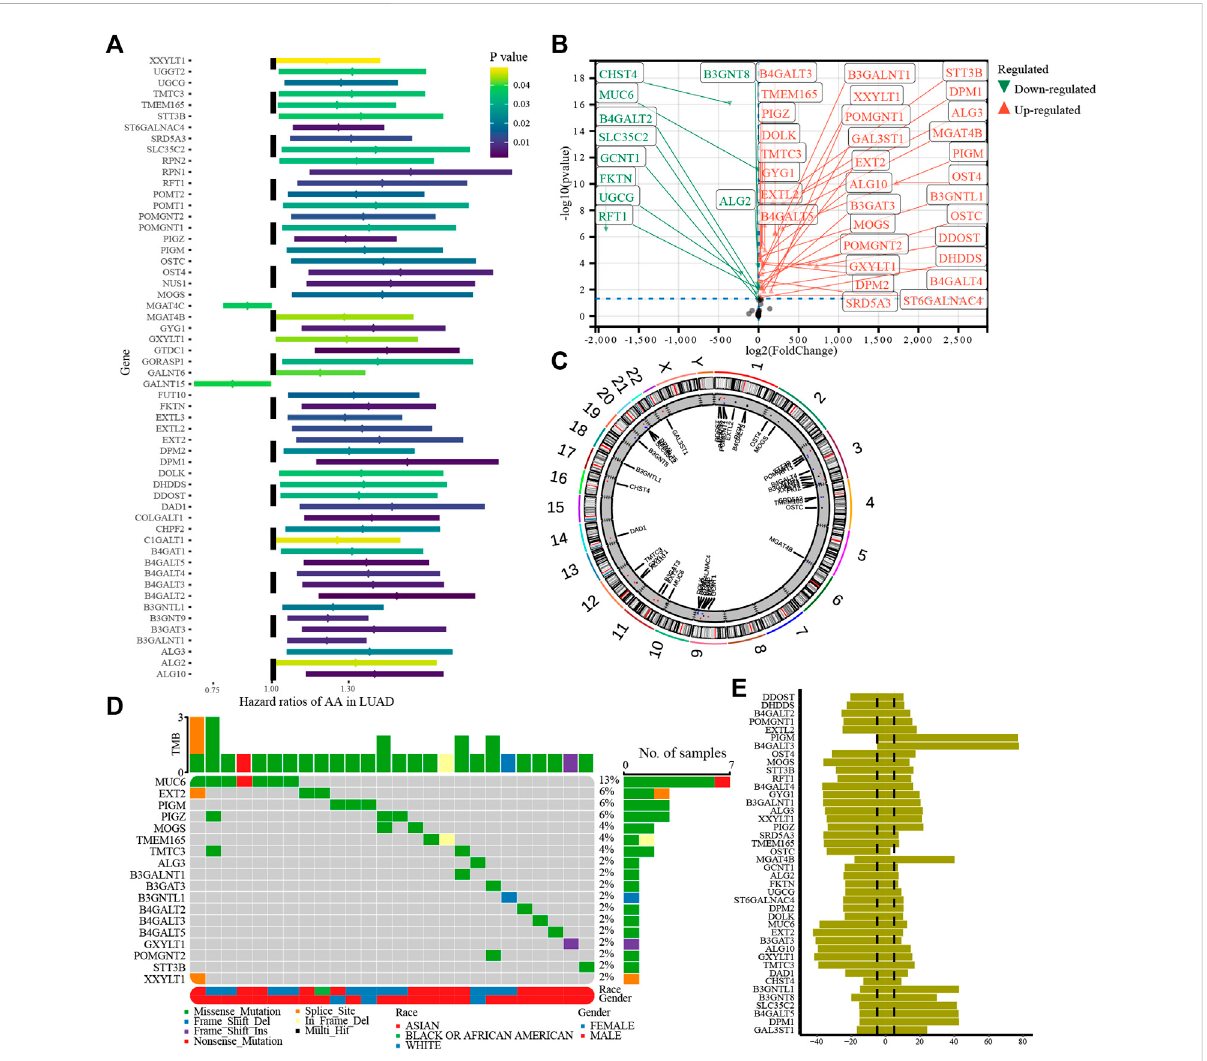
FIGURE 2 Genetic variation in glycosylation-regulatory genes in HCC. (A) . Univariate Cox regression analysis of glycosylation regulatory genes; (B) . Differential expression of glycosylation regulated genes with prognostic value; (C) . Location of 43 differentially expressed genes with prognostic value on the chromosome; (D) . Gene mutation of glycosylation regulator; (E) . CNV of glycosylation